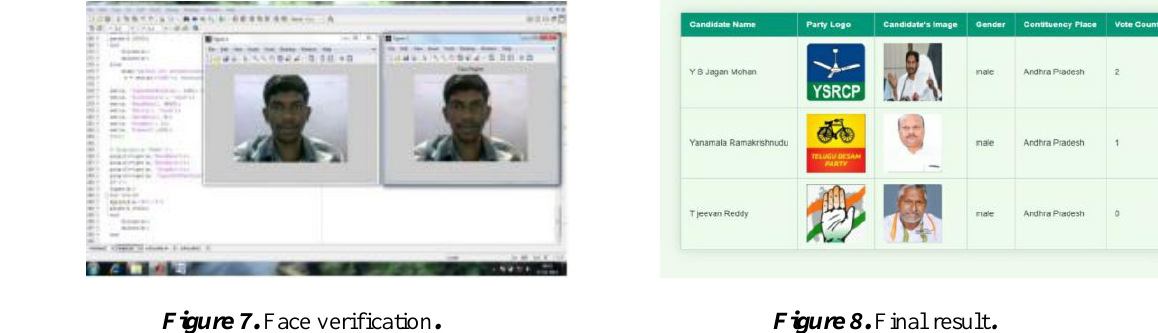
Figure 7. Face verification . Figure 8. Final result